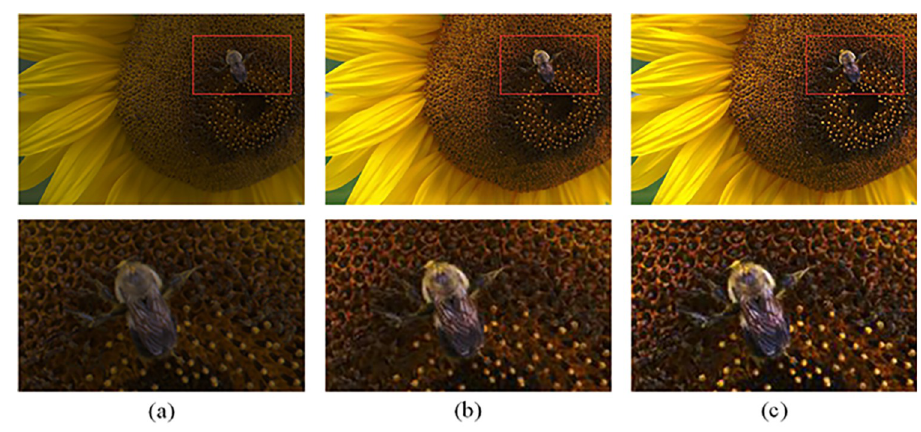
Fig 9. Image texture adding effect comparison. (a) Original image (b) Image processed by DHEDAPL (c) The image processed by DHEDAPL and adding detailed texture.